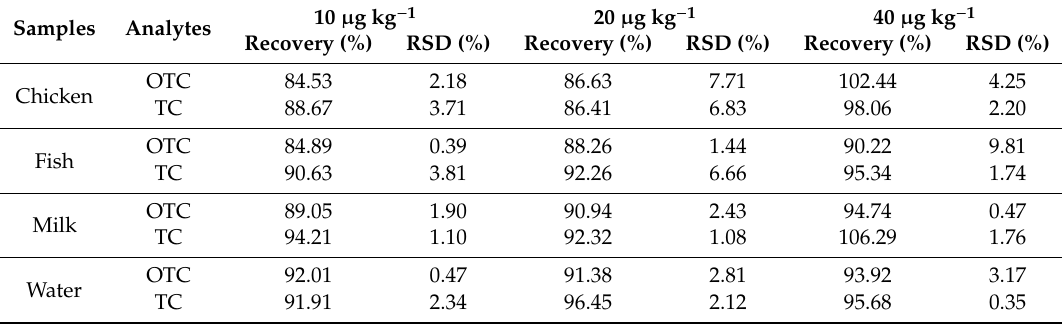
Table 4. Recoveries and relative standard deviations (RSDs) (%) obtained from the analysis of chicken, fish, milk and water samples spiked with